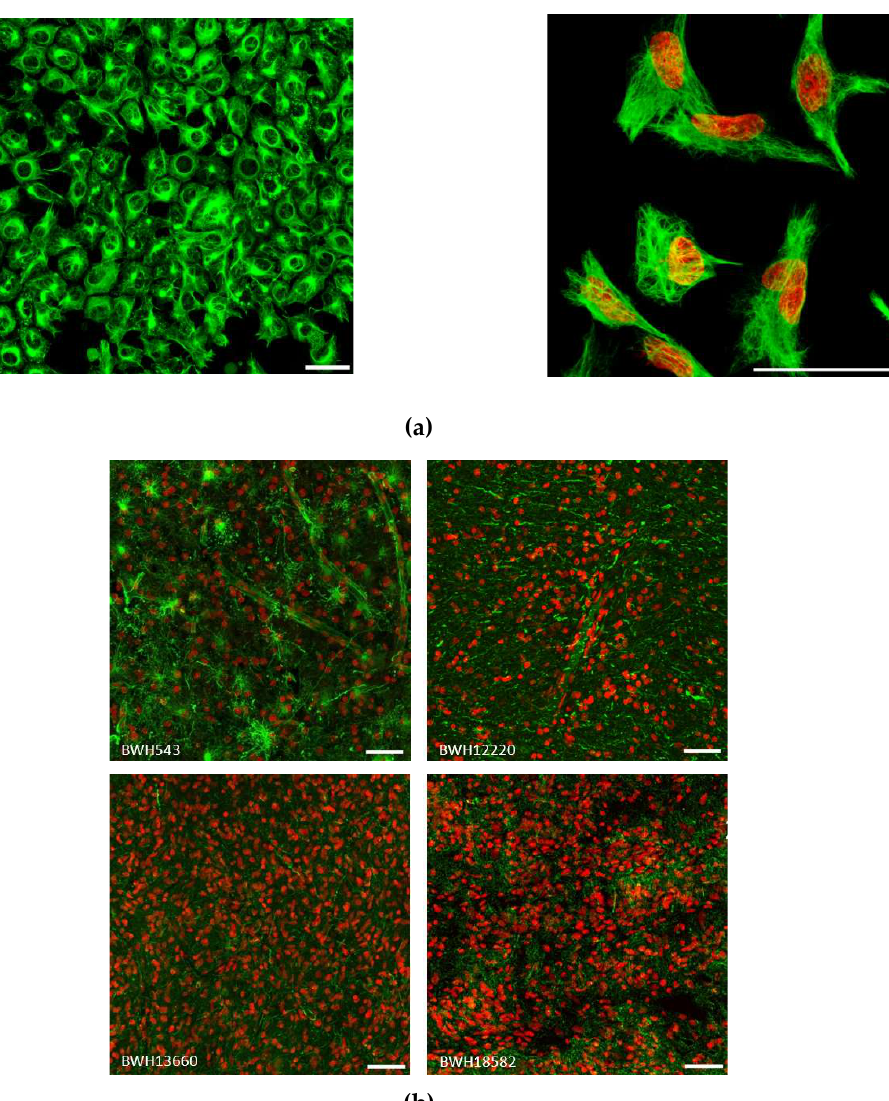
Figure 3. Vimentin staining in human GBM: ( a ) U251 cells grown as monolayers (left panel, field of view 400 by 400 μm, scale 50 μm) and high magnification (right, scale bar = 50 μm) of single cells, vimentin staining is presented here as a high dynamic range (HDR) image showing the perinuclear vimentin-rich region and fine network of filaments. ( b ) Surgically obtained human tumor specimens were stained for vimentin, field of view 400 by 400 μm, scale 50 μm.